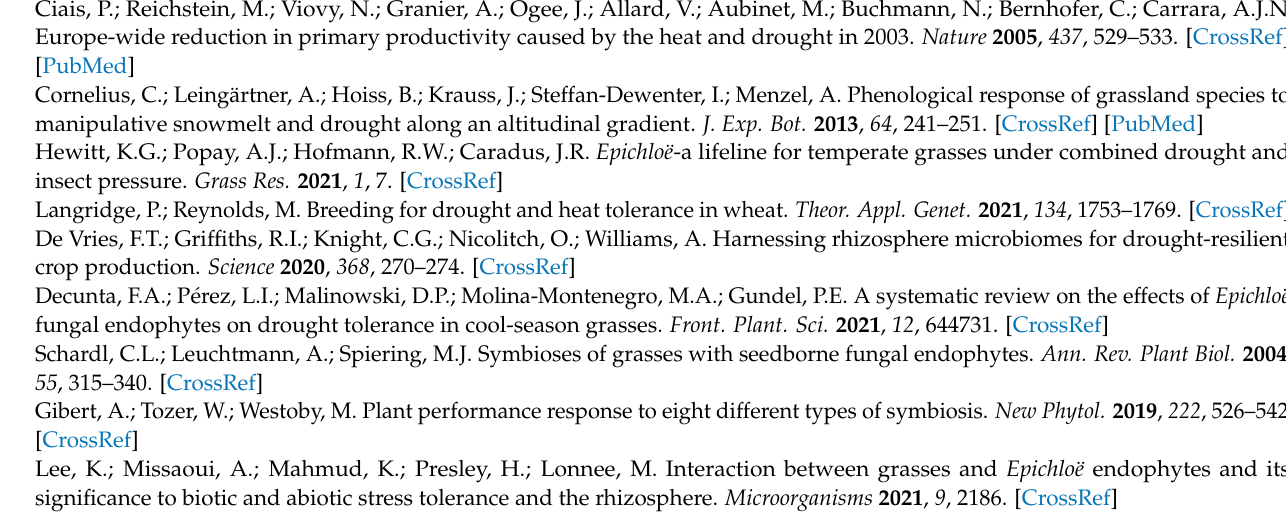
differences among corresponding water content at 0.05 level. Figure S5: The fresh weight of shoot (a) and root (b), and dry weight of shoot (c) and root (d) of Epichloë symbiotic (EI) and non-symbiotic (EF) Achnatherum inebrians plants under normal (CK), moderate (MD) and severe (SD) drought treatments. The asterisk (*) means significant difference at p < 0.05 (independent t -test) between and EI and EF plants at corresponding water content at 0.05 level. The A and B mean significant differences among corresponding water content at 0.05 levels. Table S1: Selected unigenes associated with processes of photosynthesis and photosynthesis-antenna proteins identified in the RNA-seq analysis in the present study. Table S2: The comparative statistics between RNA sequencing clean data and transcriptome assembly of Epichloë symbiotic (EI) and non-symbiotic (EF) Achnatherum inebrians plants under normal (CK), moderate (MD) and severe (SD) drought treatments. Table S3: Length distribution of transcripts and unigenes of Achnatherum inebrians plants. Table S4: Unigenes statistics of Achnatherum inebrians plants transcriptome against eight different public databases. Table S5: The ANOVA table showing the effects of symbiosis status and soil moisture levels on the growth partners, biomass, chlorophyll content and photosynthetic indices of Achnatherum inebrians